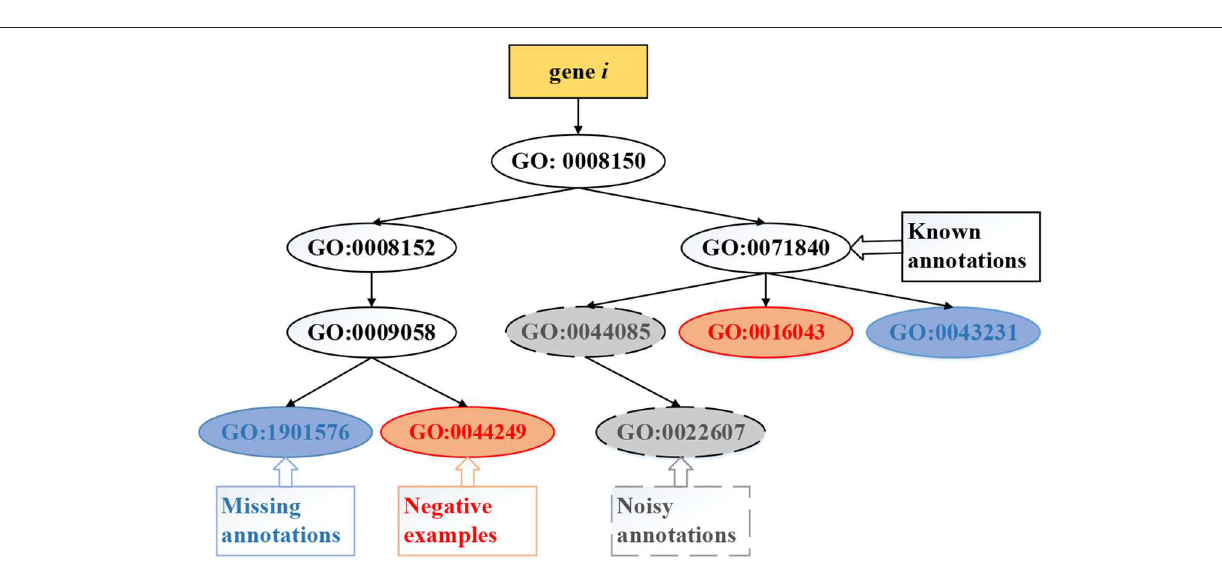
FIGURE 4 | Exemplar tasks of gene function prediction, which include predicting missing , negative , and noisy